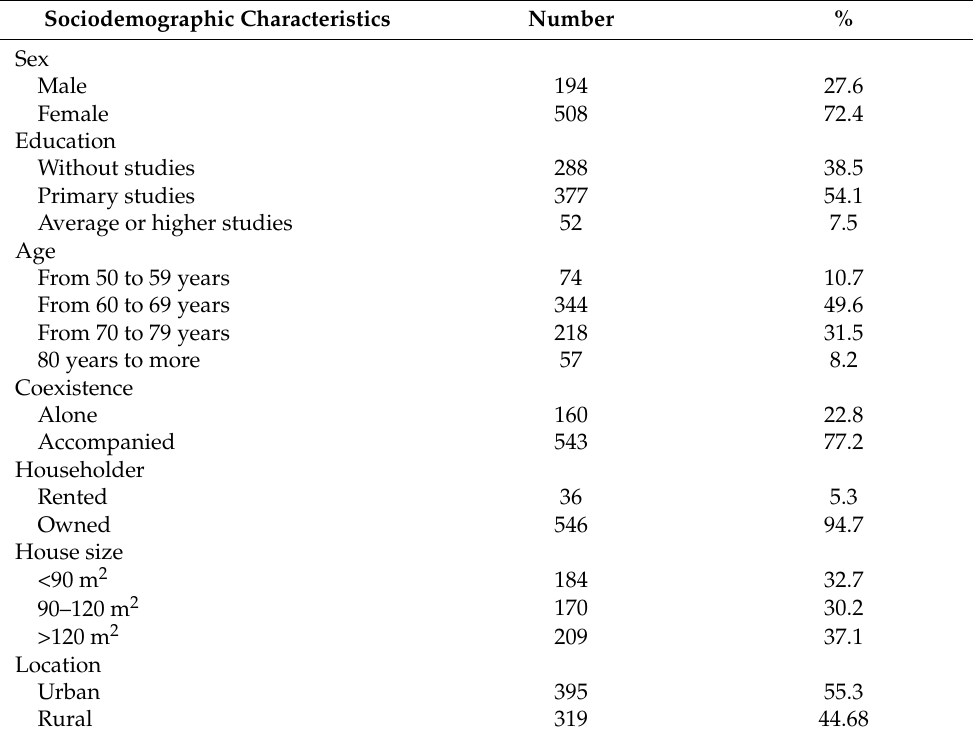
Table 1. Sociodemographic characteristics of the